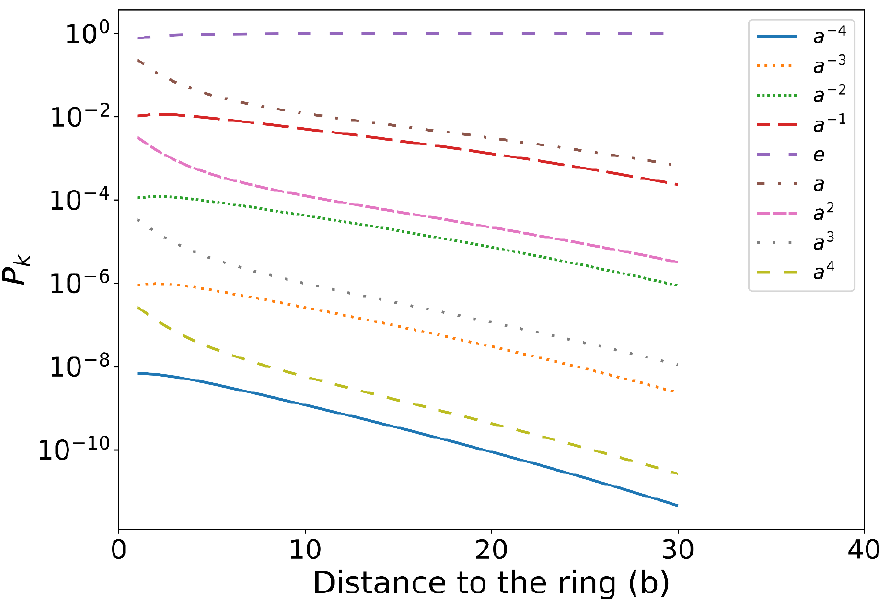
Figure 3. The probability of an ideal chain with the free end being found within the subspace 𝑔 = 𝑎 𝑘 and another end fixed at a point in subspace 𝑒 . The 𝑥 -axis shows the distance of the free end to the ring plane in the unit of Kuhn length 𝑏 . Note that the probability function is normalized over 𝑔 , i.e., ∑ 𝑃 𝑔 (ⅆ) 𝑔 = 1 ). Here, the ring with overall radius 3𝑏 and the fixed end of the chain are both fixed at ( 𝑟 = 0 and 𝑧 = 0 ).